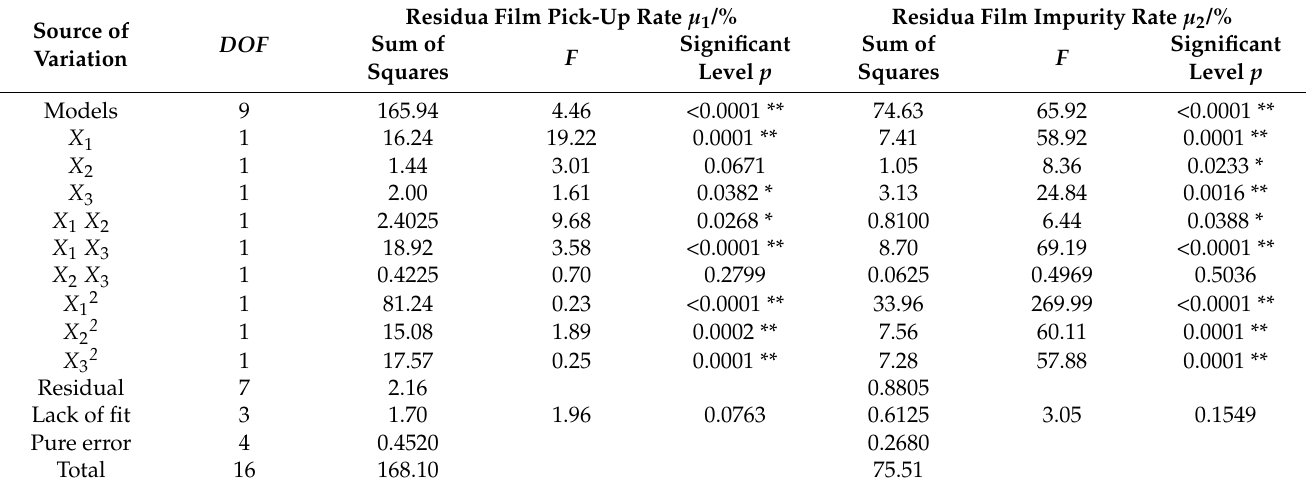
Table 4. The analysis of variance of the regression equation.